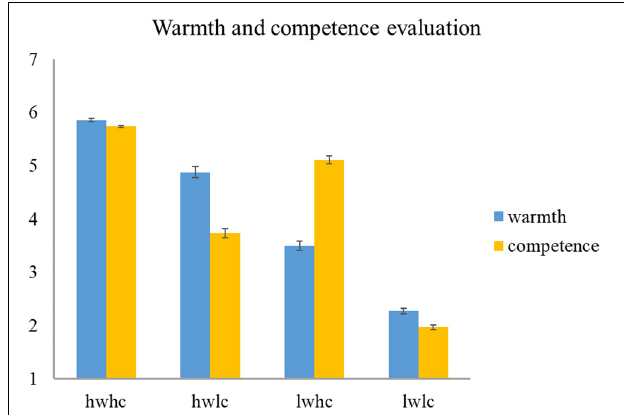
FIGURE 1 | Descriptive statistics for warmth and competence in four categories (hw, high warmth; lw, low warmth; hc, high competence; lc, low